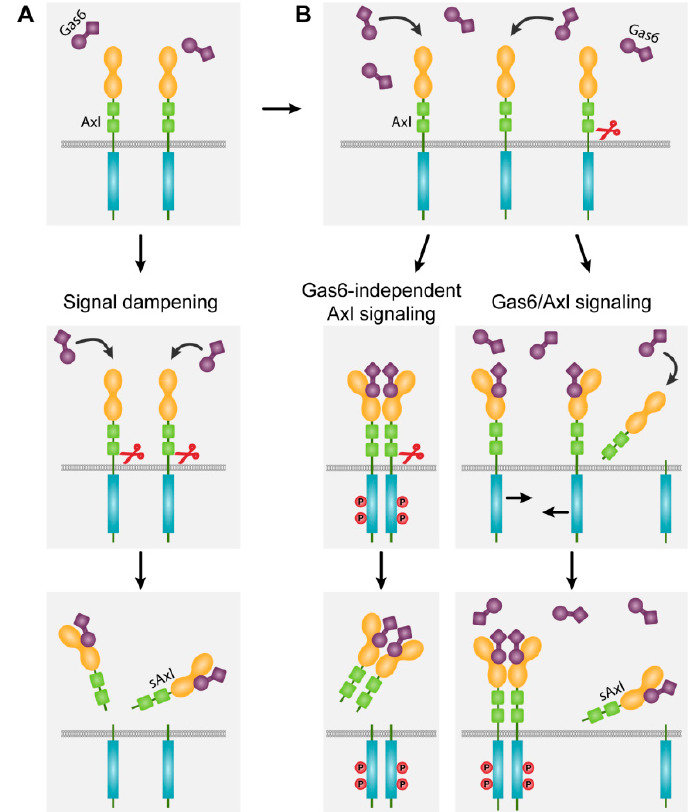
Figure 4. Axl signaling in liver fibrosis and HCC after ectodomain shedding. ( A ) Dampening of Gas6/Axl signaling. The monomeric Axl receptor is cleaved by proteases resulting in sAxl monomers that bind to and trap free Gas6. ( B ) Gas6-independent and Gas6-dependent Axl signaling. Middle left and lower panel: proteases cleave Gas6/Axl tetramers releasing sAxl dimers. Signaling of Axl receptor lacking the extracellular domain is questionable. Middle right and lower panel: In the presence of Gas6/sAxl complexes, abundant free Gas6 binds to Axl allowing homo-dimerization of receptors and activation of Axl signaling. Red scissors indicate proteolytic cleavage.